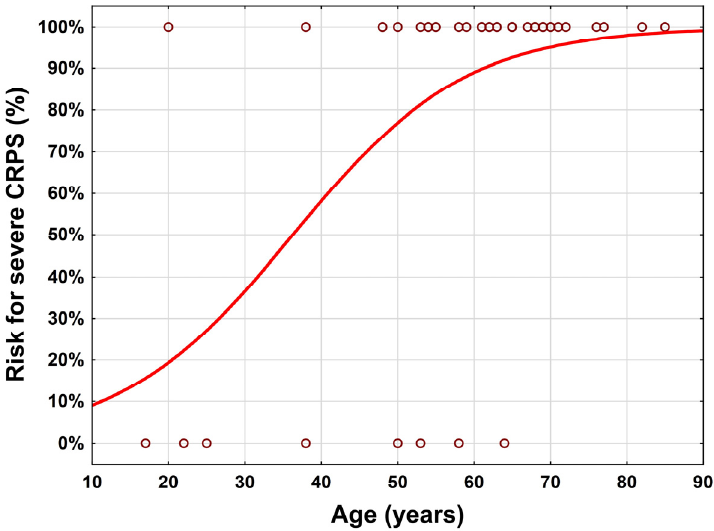
Figure 1. Risk for severe CRPS depending on age and lower extremity.